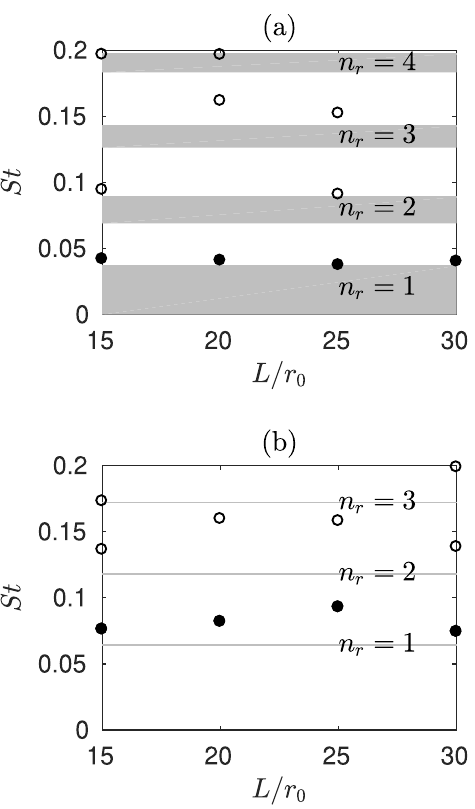
Figure 9. Strouhal numbers of the peaks in the near-nozzle pressure spectra as a function of the nozzle-to-plate distance for (a) n h = 0 and (b) n h = 1; (cid:7) dominant and (cid:8) secondary peaks. The frequency bands of the upstream-propagating guided jet waves are in grey.